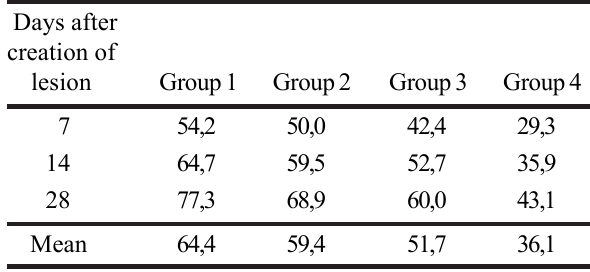
TABLE 1 - Resultant means from the histomorphometric analyses on bone neoformation